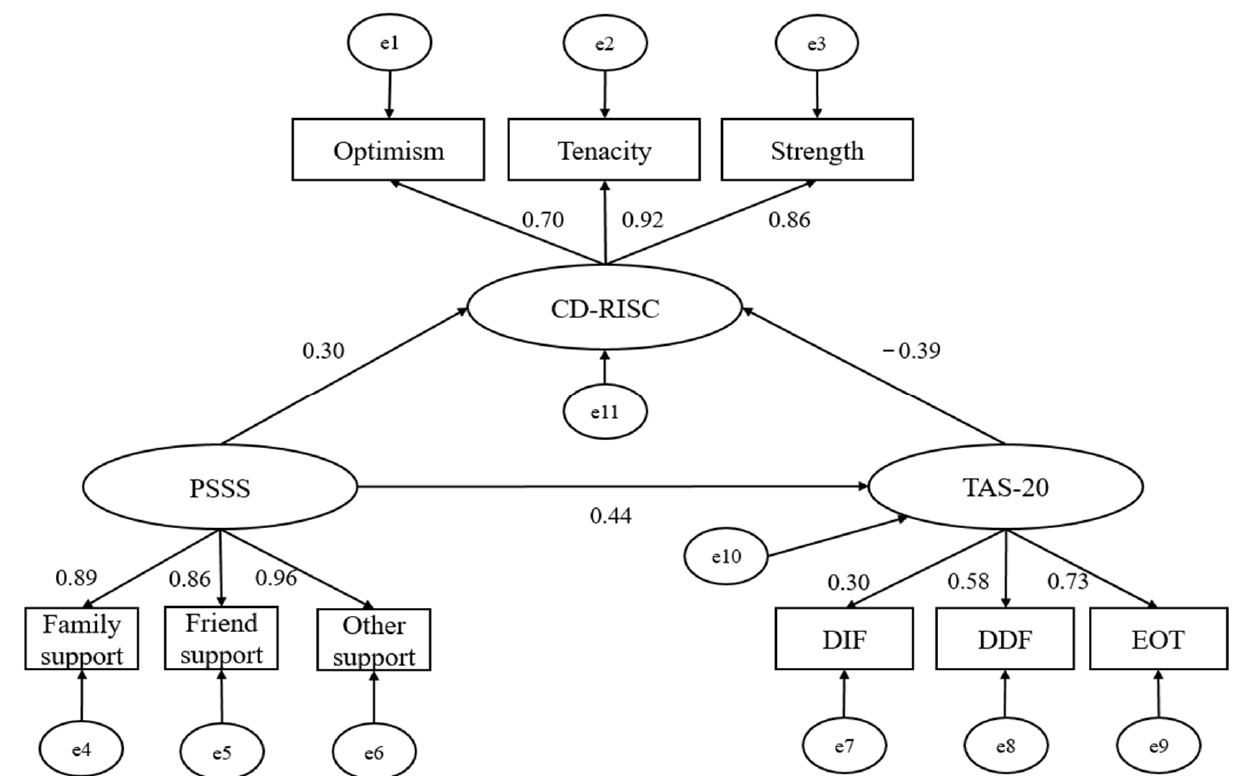
Figure 1. The mediating path of alexithymia between psychological resilience and perceived social support. PSSS: Perceived Social Support Scale; TAS-20: Toronto Alexithymia Scale; CD-RISC: Connor-Davidson Resilience Scale; DIF: difficulty identifying feelings; DDF: difficulty describing feeling; EOT: externally oriented thinking; e1–11: error 1–11, arrow: pathway, number: standardized estimates. Table 3. Regression analysis of influencing factors of